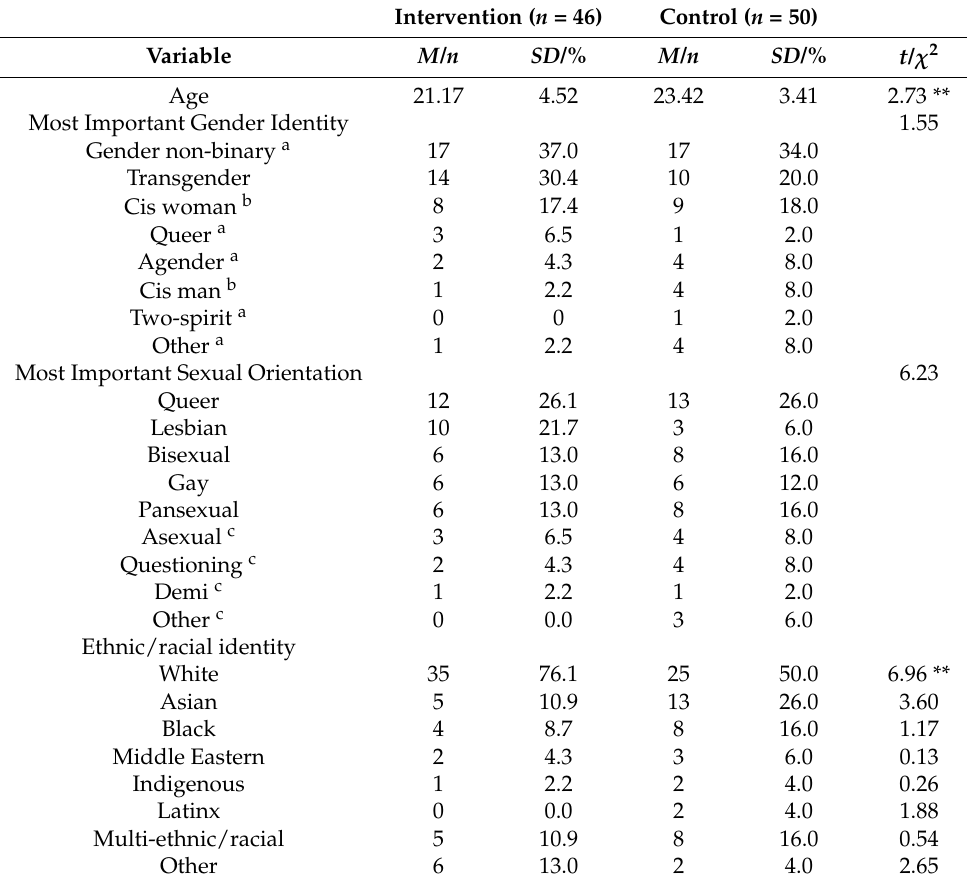
Table 1. Demographics comparison of sample ( n =